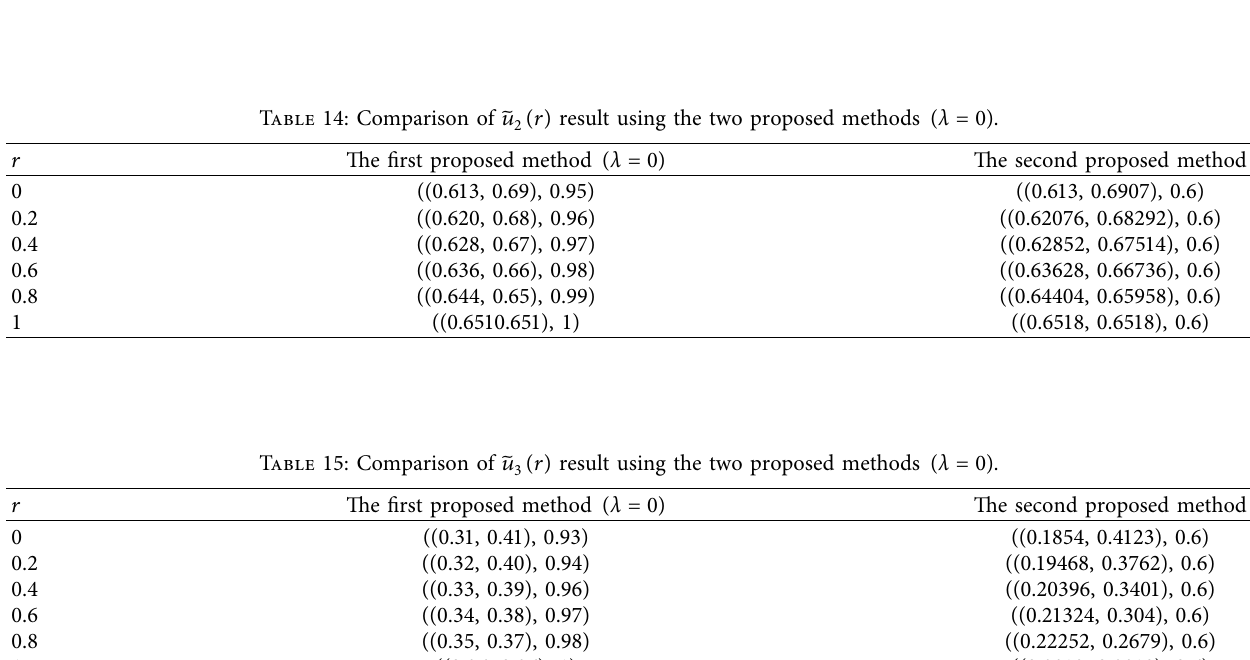
Table 14: Comparison of 􏽥 u